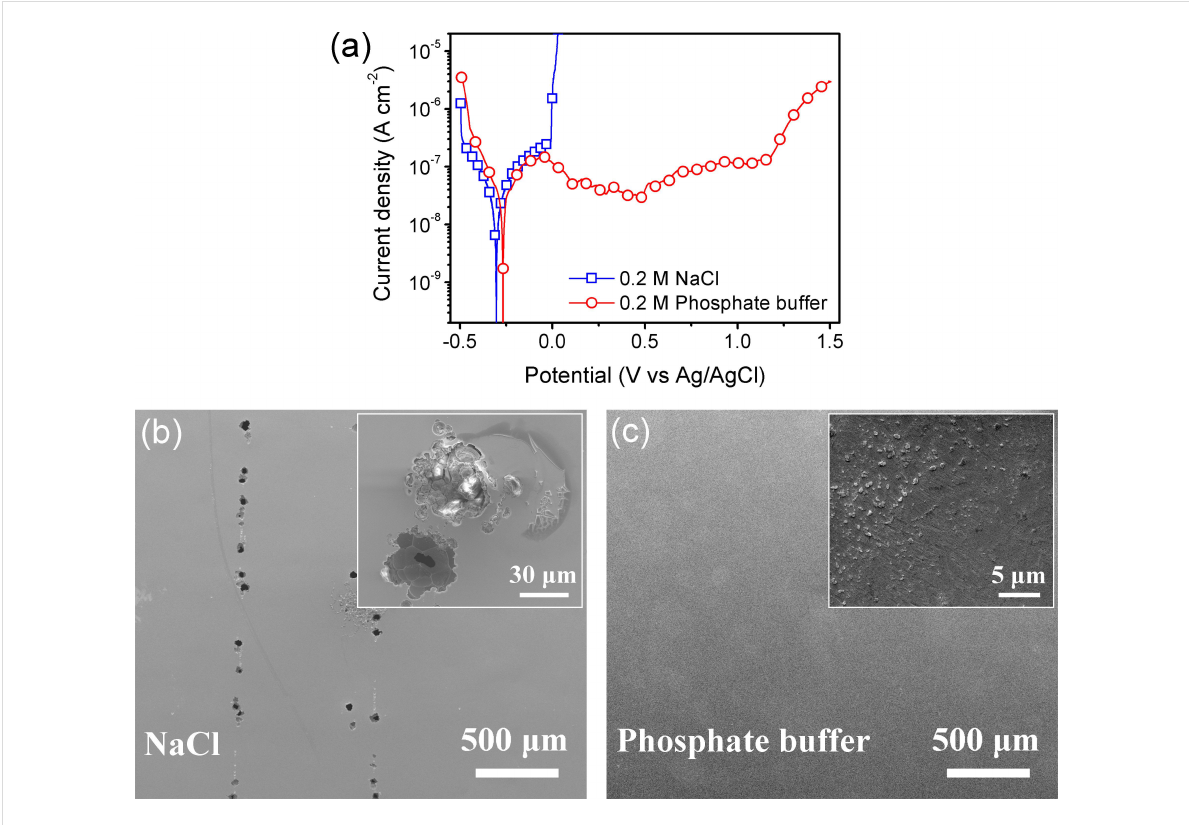
Figure 1: (a) Potentiodynamic polarization curves of Zr 63 Ni 22 Ti 15 metallic glass in 0.2 M NaCl solution and 0.2 M phosphate buffer recorded in an electrochemical AFM cell. SEM images of the corroded surface after potentiodynamic polarization test in (b) NaCl solution and (c) phosphate